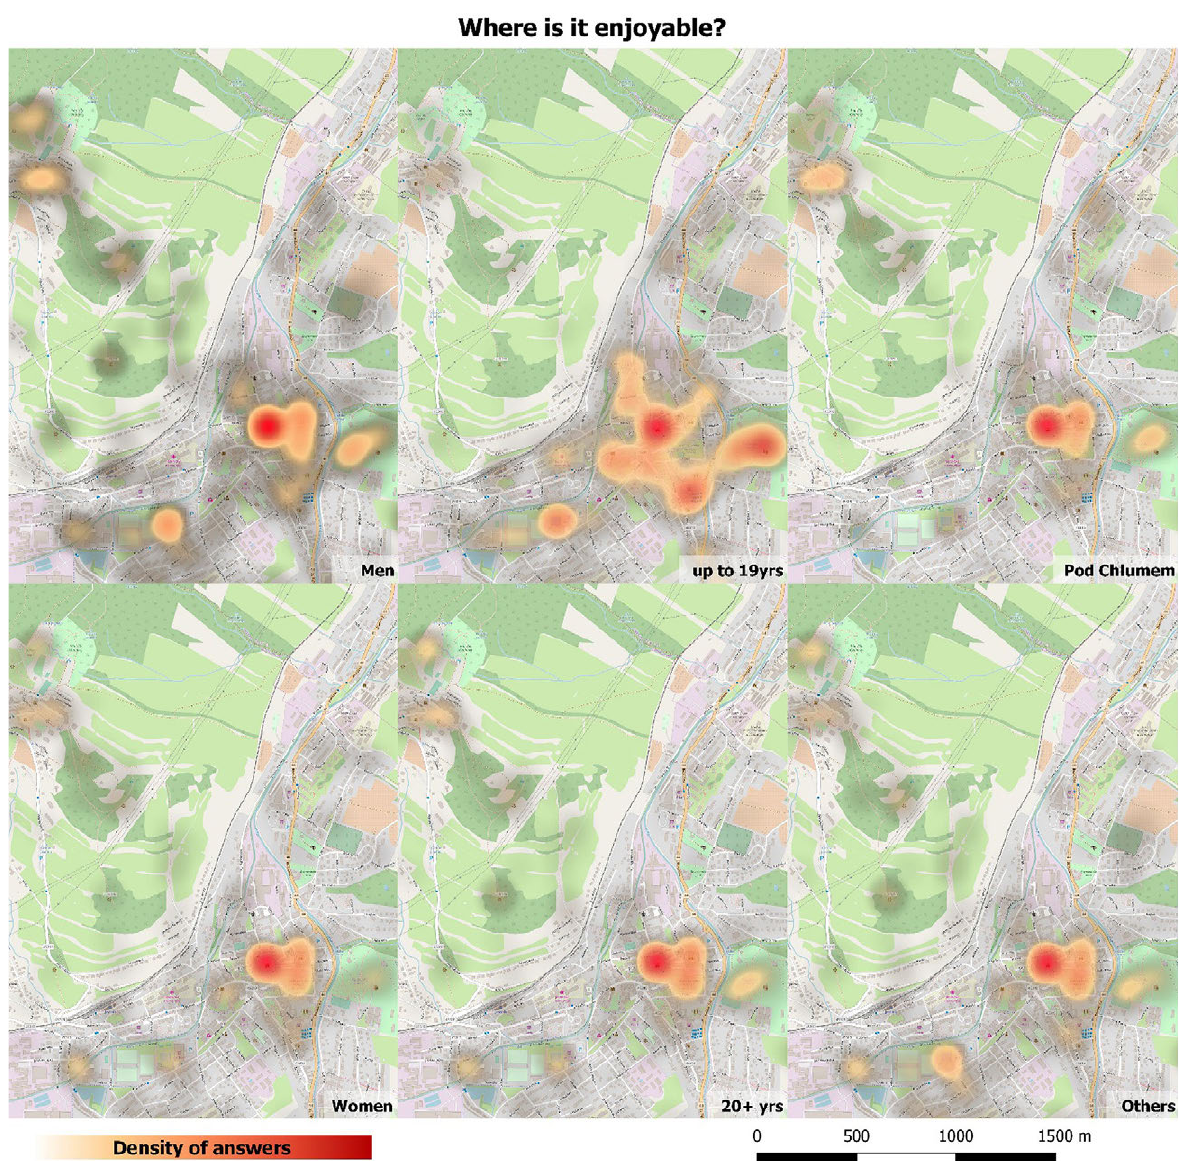
Fig. 10. Differences among selected groups´ answers to the question Where is it enjoyable in